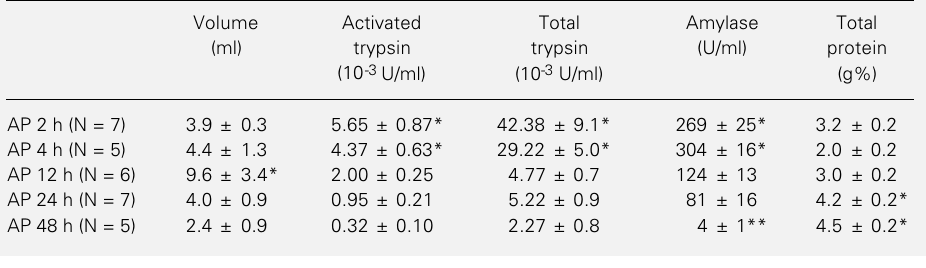
Table 2 - Analysis of pancreatitis-associated ascitic fluid in rats. Data are reported as means – SD. *P<0.05 compared to other groups without asterisk; **P<0.05 compared to 2, 4, 12, 24 h (analysis of variance). U/ml Trypsin = (cid:181)mol of substrate released per ml per min. U/ml Amylase = mg of substrate released per min per ml. AP = Acute pancreatitis.